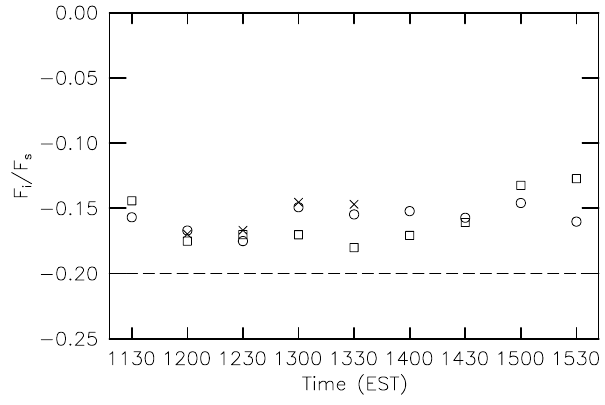
Fig. 7. The turbulent diffusive heat flux at the interface F i (scaled by F s ) computed by different methods, for the times indicated in ) ( ◦ ); by e w 0 f 2 0 (z i ) ( (cid:3) ); by Eq. (18) at z = z ∗ Table 1: by ϕ d (z ∗ i ing the turbulent diffusivity K L averaged over the interfacial layer ( × ); by − 0 . 2 F s (dashed